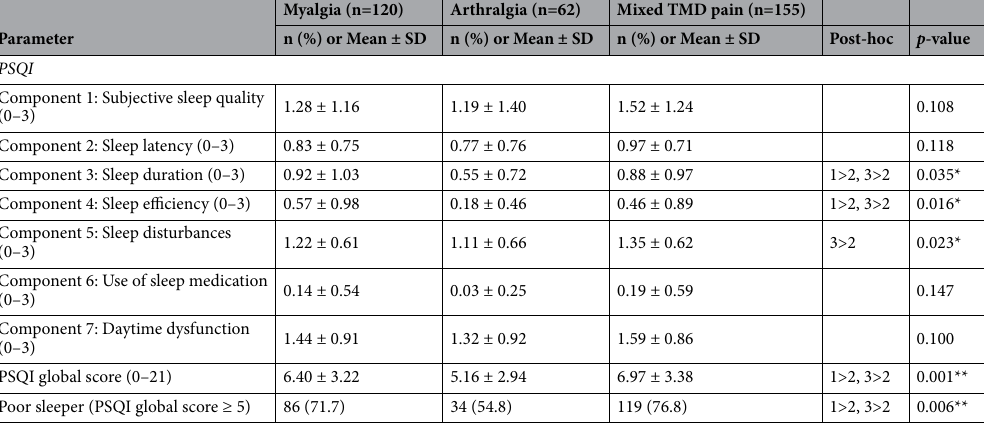
The daytime sleepiness score was higher among patients with mixed TMD pain than in those with myalgia under two conditions: sitting inactive in a public place and lying down to rest in the afternoon when circum- stances permit. In the condition of sitting quietly after lunch without alcohol, the degree of daytime sleepiness in the mixed TMD pain group was higher than that in the arthralgia group. In the case of being a passenger in a car for an hour without a break, daytime sleepiness was higher in the mixed TMD group than in the myalgia and arthralgia groups. However, there was no significant difference between groups in the degree of daytime sleepiness in the following four conditions: sitting and reading, watching TV, sitting and talking to someone, and stopping for a few minutes in traffic in a car. Correlations between PSQI global scores and other factors. Figure 1 shows the results of Spear- man’s correlation analysis between the PSQI global scores and all other variables examined in this study. The specific related factors and their correlation strengths were different for each group. In the myalgia group, psychological distress (r=0.306, p <0.001) strongly correlated with PSQI global score. In the mixed TMD pain group, tinnitus (r=0.195, p =0.015) and headache (r=0.293, p =0.001) significantly correlated with PSQI global score. Self-reported sleep problems investigated using dichotomous questions positively correlated with the PSQI global score in all three groups (myalgia: r=0.552, p <0.001; arthralgia: 0.359, p =0.004; mixed TMD pain: r=0.486, p <0.001). The correlation between the PSQI global score and psychological profiles was remarkable. The psychological profiles of the three groups significantly correlated with sleep quality. Regarding the nine subscales of the SCL- 90R, all nine subscales correlated with an increase in PSQI global scores, and all subscales excluding hostility significantly positively correlated with PSQI global scores in the mixed TMD pain group. Total ESS scores sig- nificantly positively correlated with PSQI global scores only in the arthralgia group (r=0.303, p =0.017). In all three groups, demographics such as age and sex, VAS, and mouth opening limitation did not show any significant relationship with PSQI global scores. Predicting the factors influencing sleep quality.